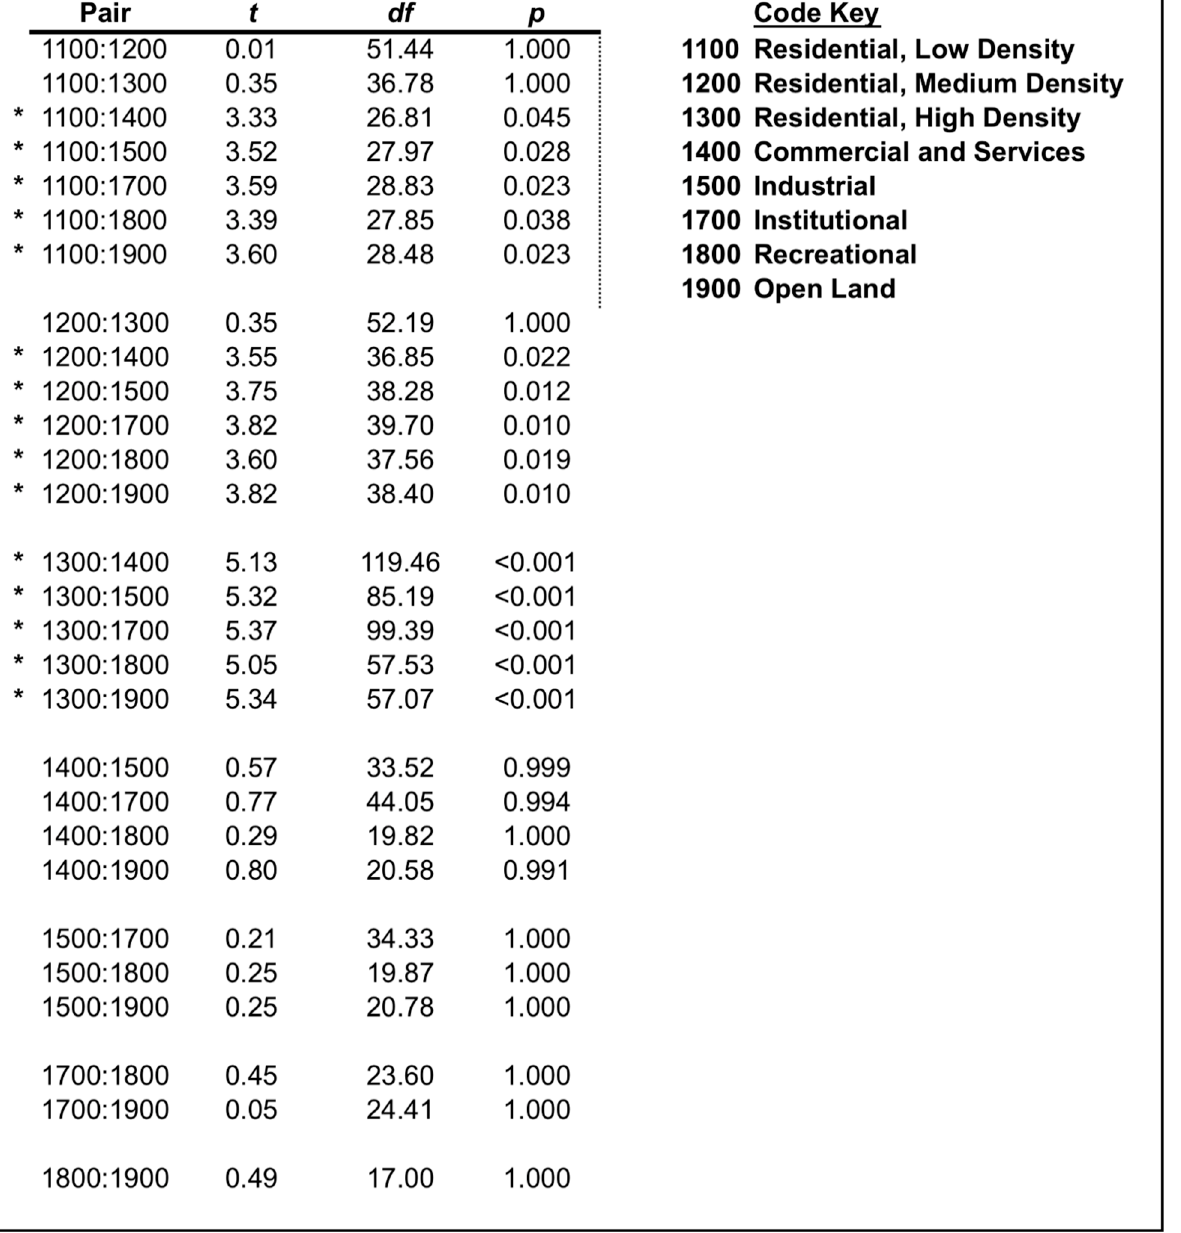
Figure 3. Games–Howell pairwise comparisons of AGTC kg plot − 1 between sub-classes of the “Urban and Built-up” Level I SWFWMD class. Significantly different sub-classes (at α = 0.05) are denoted with an asterisk.